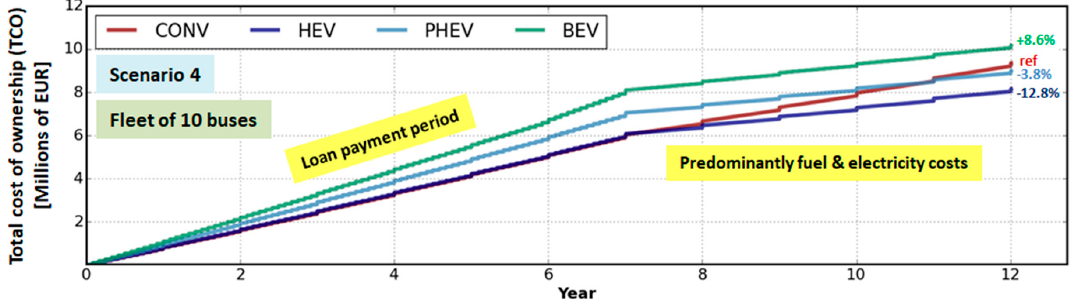
Figure 20. TCO time profile for different bus fleet types and Scenario 4 from Figure 18.